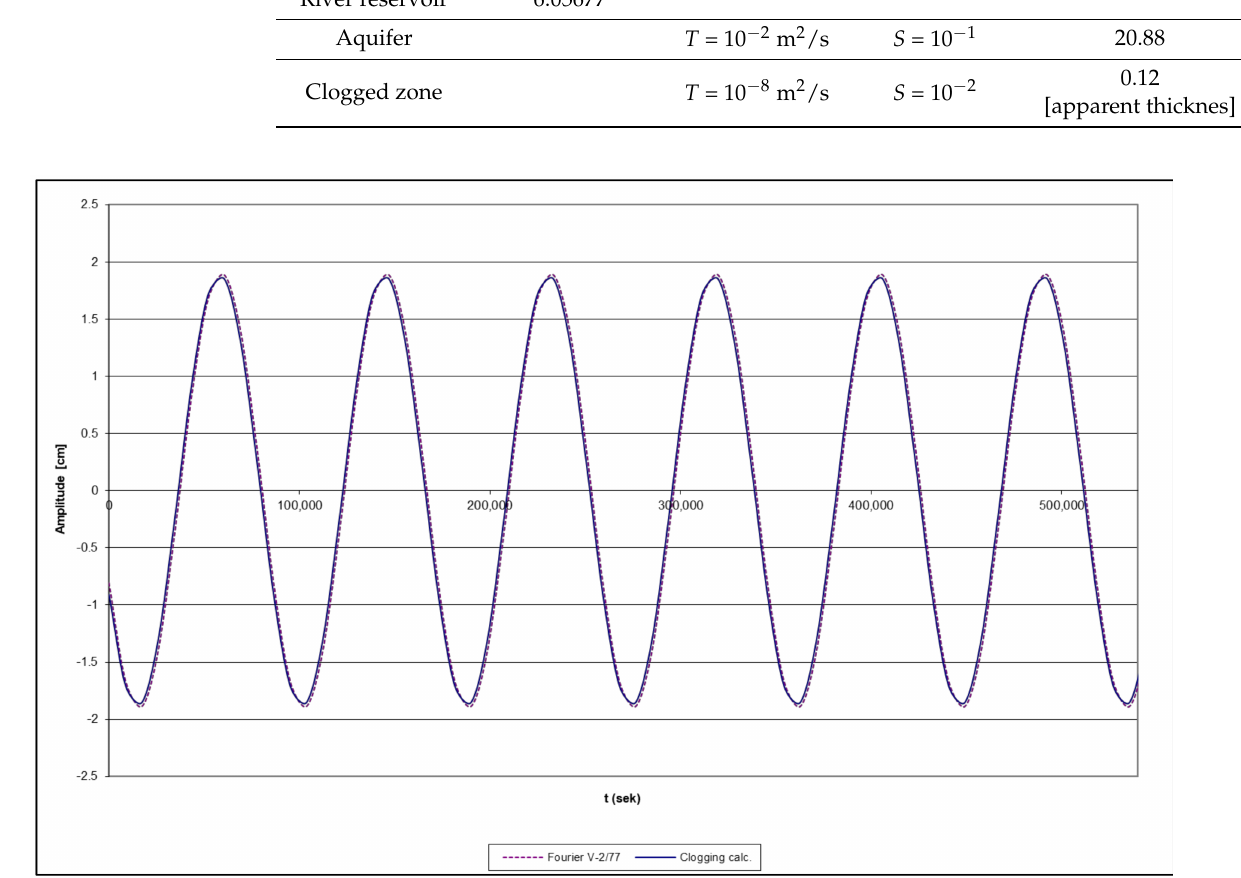
Figure 13. Best fitting of calculated values from data in Table 3 to values computed by Fourier